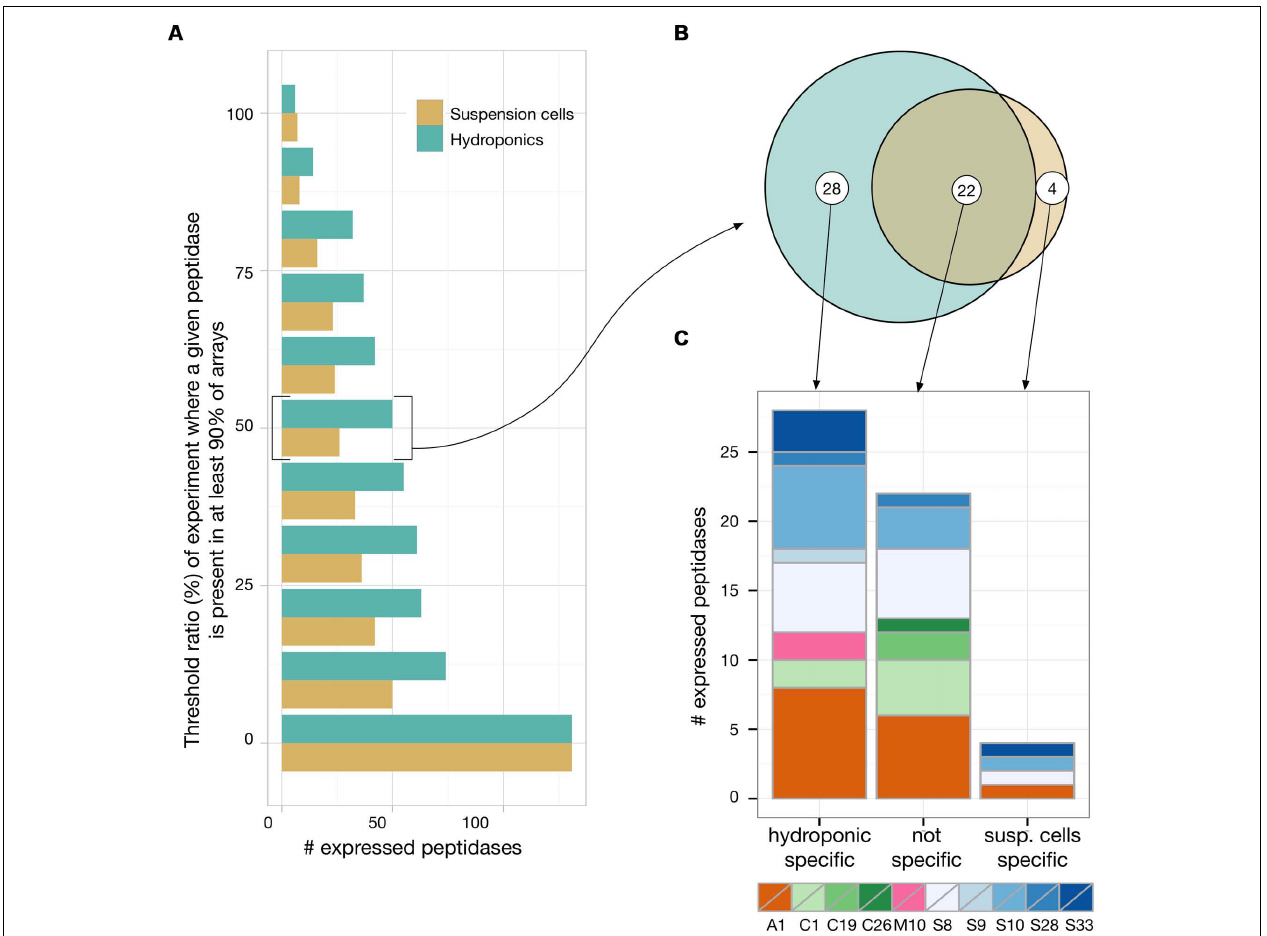
FIGURE 5 |Transcriptomic analysis of Arabidopsis secreted peptidases by a meta-analysis of publicly available microarrays data of hydroponic and suspension cell experiments. A present/absent call ( p < 0.01) was applied to each peptidase in each arrays of each experiment available. For each experiment, a peptidase was considered as ‘present’ if detected in at